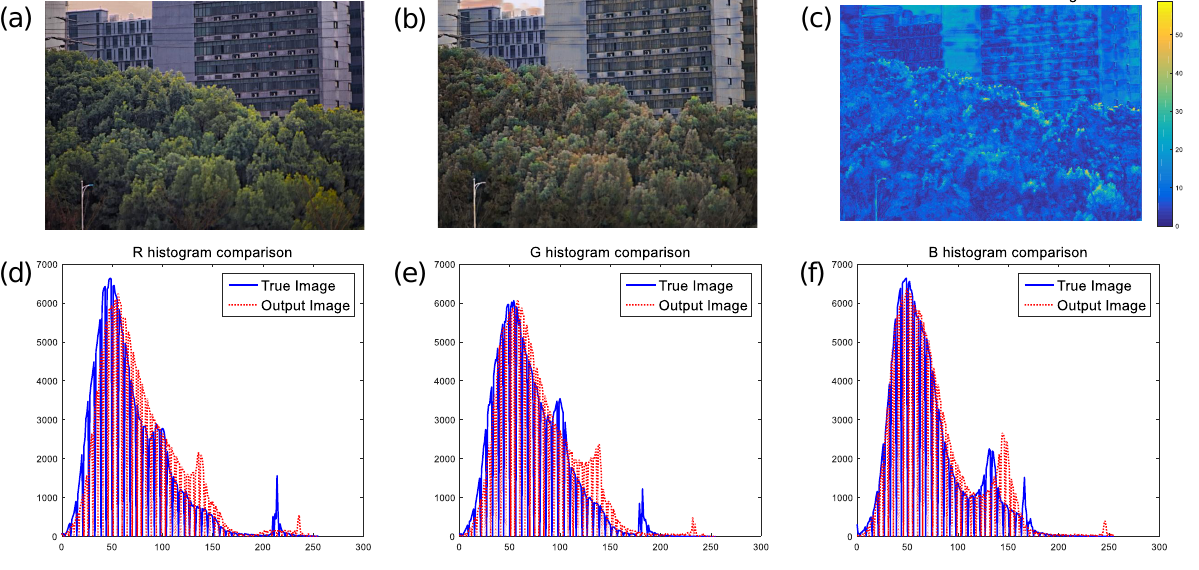
Figure 11. Quantitative evaluation of color images. ( a ) The true image; ( b ) the output image; ( c ) the chromatic aberration diagram; and ( d – f ) histogram comparison of the R, G, and B